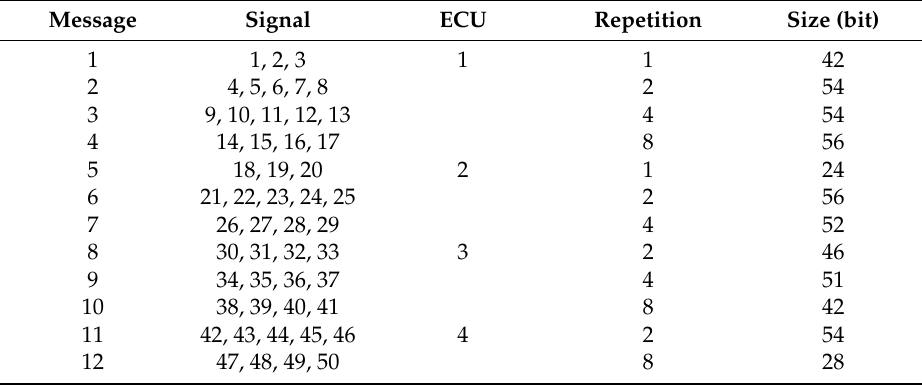
Table 6. Signal packing for Next Fit Decreasing (NFD)